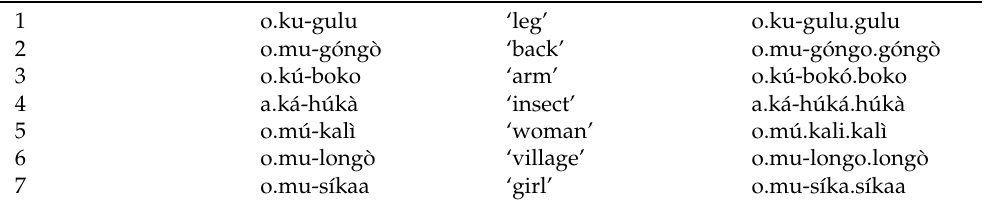
The augment falls outside the scope of reduplication. Reduplication for